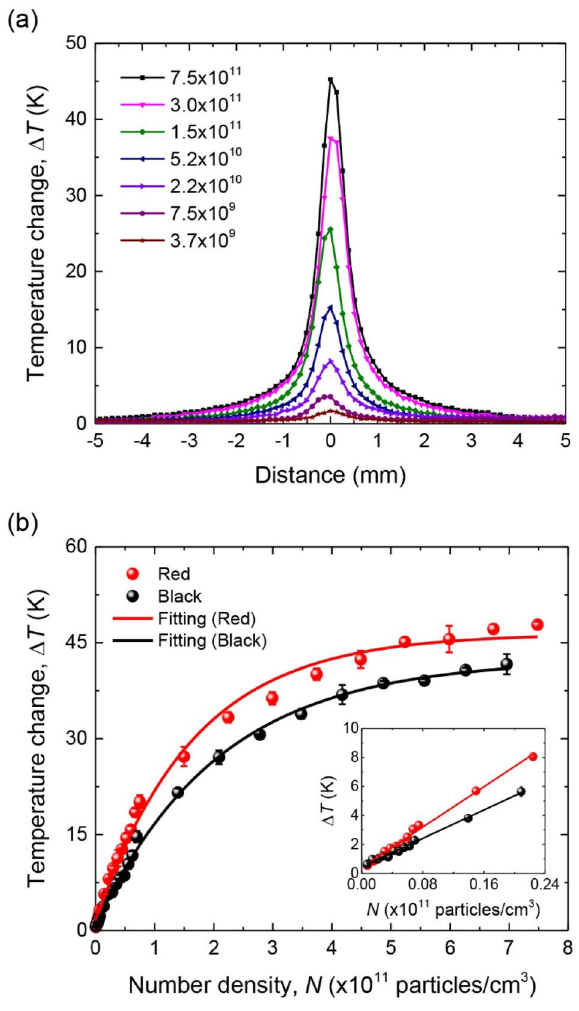
Figure 6. Photothermal detection of CLBs on NC membrane. ( a ) Variations of the spatial temperature profiles of laser-irradiated red latex beads on NC membrane with their number densities. ( b ) Dependence of the peak temperature rises of laser-irradiated red and black latex beads on their number densities. The effective absorption cross sections of both particles are obtained by fitting the experimental data to Eq. (5) in text. Inset: enlarged view of the data in low number density regions. Solid curves are best fits of the experimental data with a linear function. The small (cid:31) T offset at N = 0 is due to laser heating of blank samples on NC